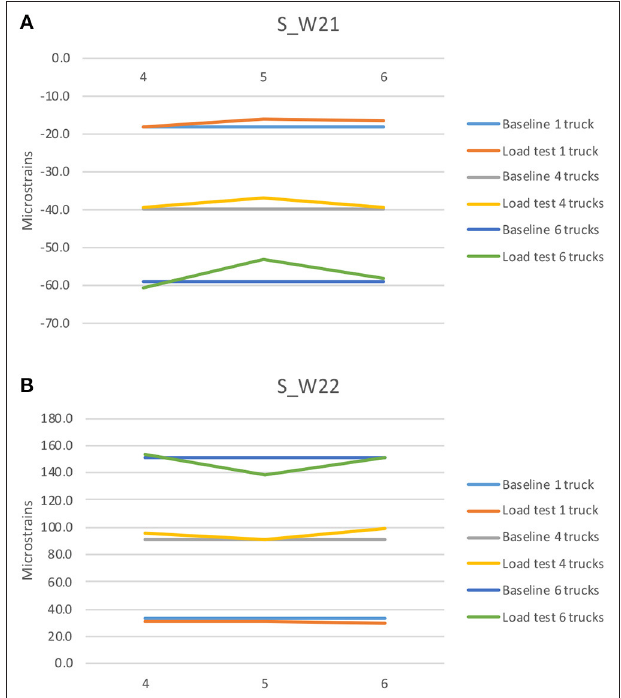
FIGURE 7 | Peak strains at the controlling location from load tests 4, 5, and 6 compared to the baseline value: (A) top of west edge girder; (B) bottom of west edge girder.